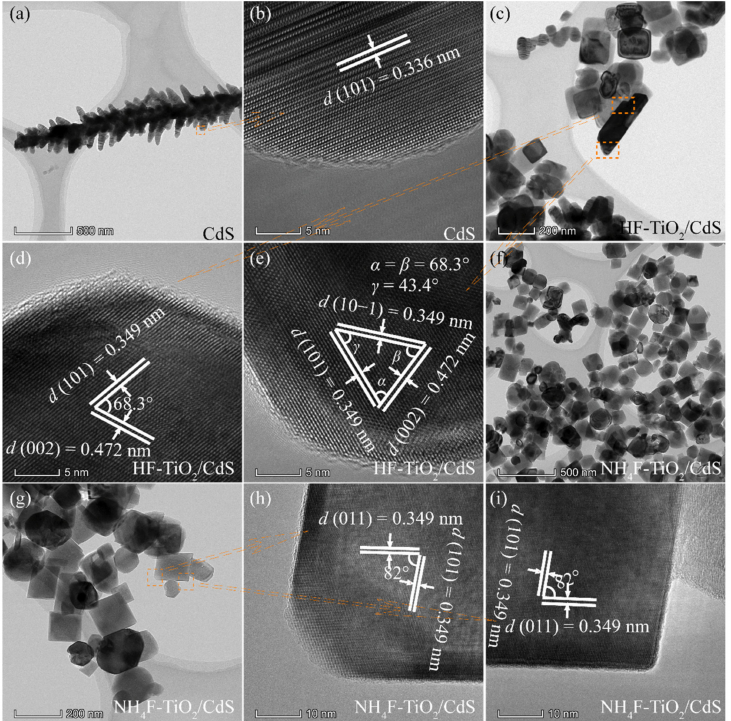
Figure 4. TEM and HRTEM images of ( a , b ) CdS, ( c – e ) HF-TiO 2 /CdS, and ( f – i ) NH 4 F-TiO 2 /CdS samples.